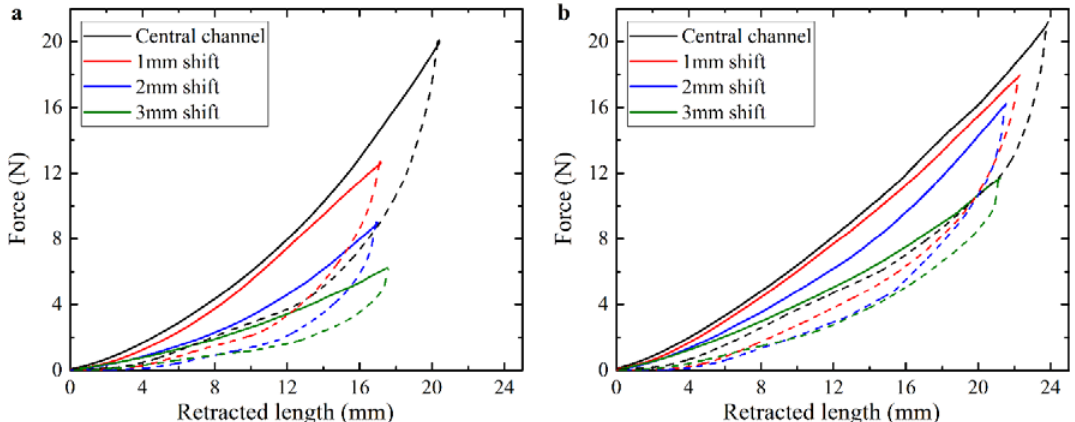
Figure 4. Force-retraction curves for TangoPlus actuator with different position of the channel without external load ( a ) and with additional 50 g, applied on the free end of the specimen ( b ). Solid curves represent loading; dashed curves are obtained during unloading.